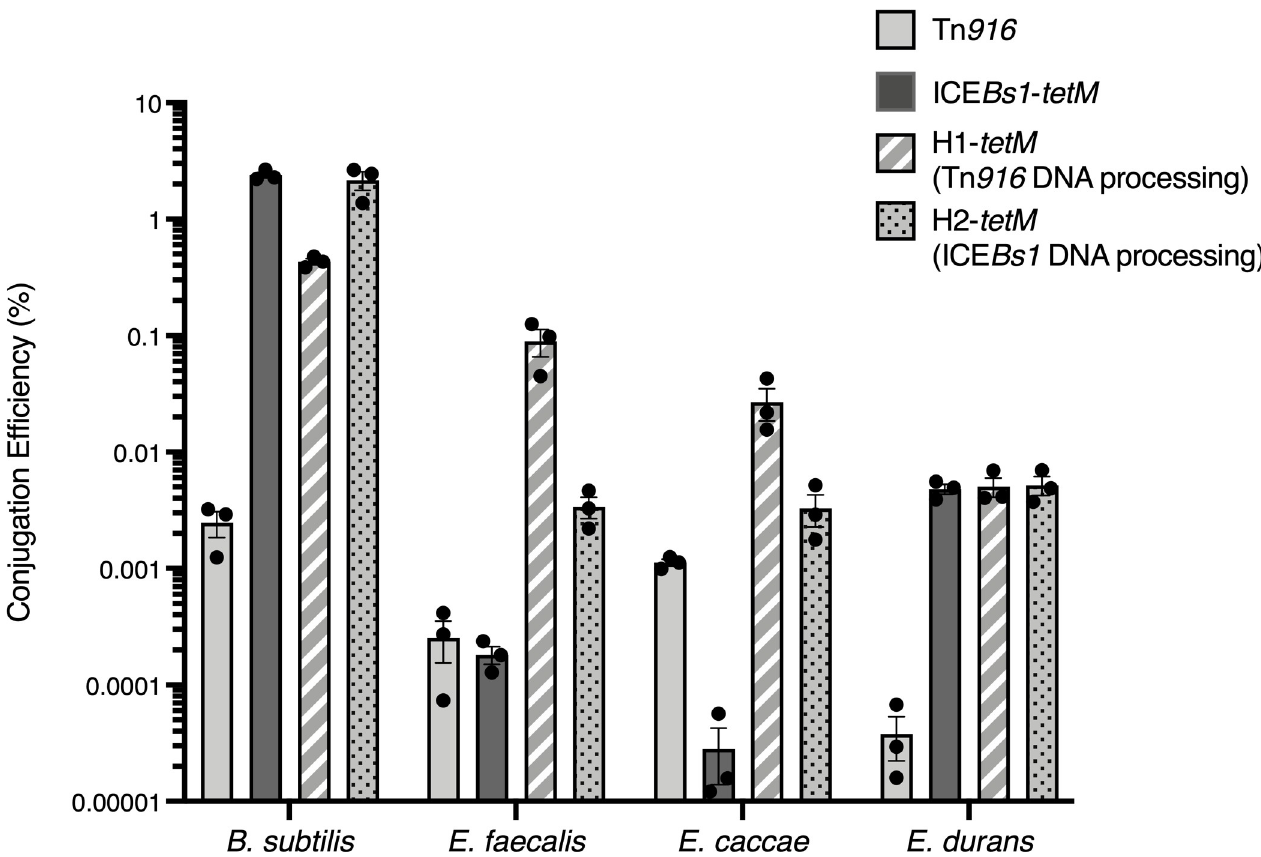
Fig 2. Element conjugation efficiencies are dependent on recipient species. Bacillus subtilis donors contained Tn 916 (ELC1566); ICE Bs1 (ELC1795); (ICE Bs1 -Tn 916 )-H1 (ELC1722); or (ICE Bs1 -Tn 916 )-H2 (ELC1725). Donors were D-alanine auxotrophs ( alr :: cat ) for counter-selection of transconjugants during mating assays. ICE Bs1 , H1, and H2 donors also contained amyE ::[(Pspank(hy)- rapI ) spc ] for IPTG-inducible overproduction of RapI to de-repress element gene expression that leads to excision (activation). Donor cells were grown to exponential phase in LB medium; IPTG or tetracycline was added as appropriate to stimulate element activation. Donors were mixed with recipients that had been grown to exponential phase in LB ( B . subtilis : CAL419) or BHI ( E . faecalis , E . caccae , and E . durans ). Mixed cells were filtered and placed on a solid surface for one hour. Conjugation efficiencies were calculated as the number of transconjugants (tetR, D-alanine prototrophs) produced, normalized to the number of donors. Bars indicated the mean of 3 independent mating assays ±